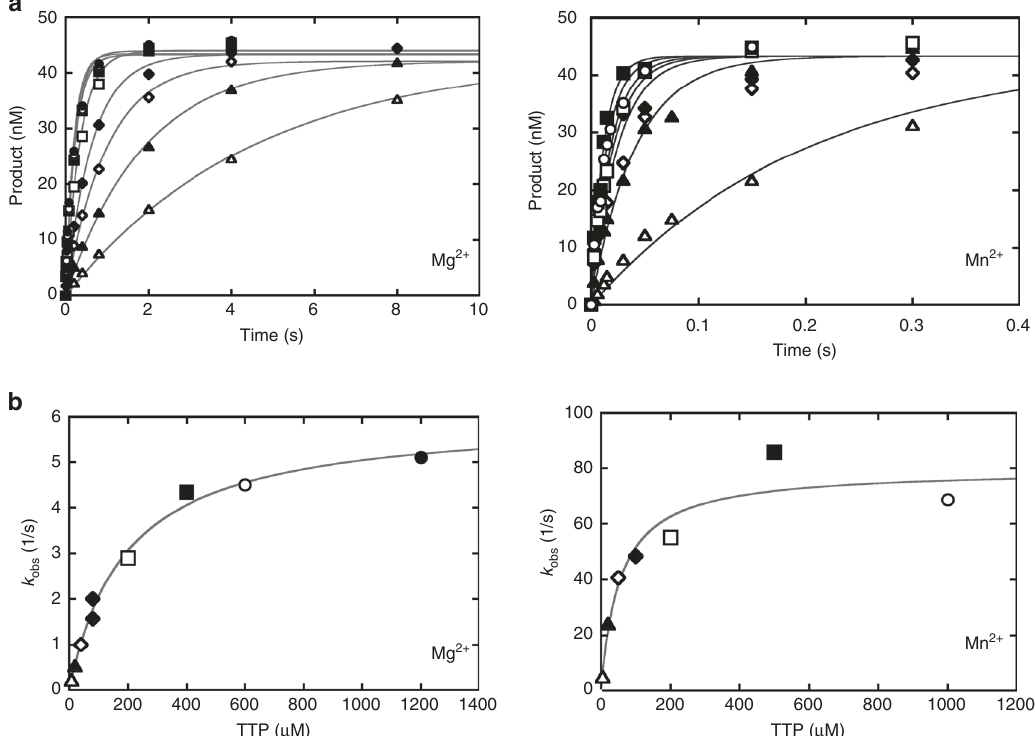
Fig. 7 Single-turnover kinetics of pol μ . a Representative time courses of Mg 2+ - ( left panel ) and Mn 2+ ( right panel )-mediated gap- fi lling insertion of TTP opposite templating dA. b Secondary plot of observed single-exponential rate constants against concentration of incoming TTP (Mg 2+ , left panel ; Mn 2+ , right panel ). The data were fi t to a hyperbolic equation to yield the values listed in Table